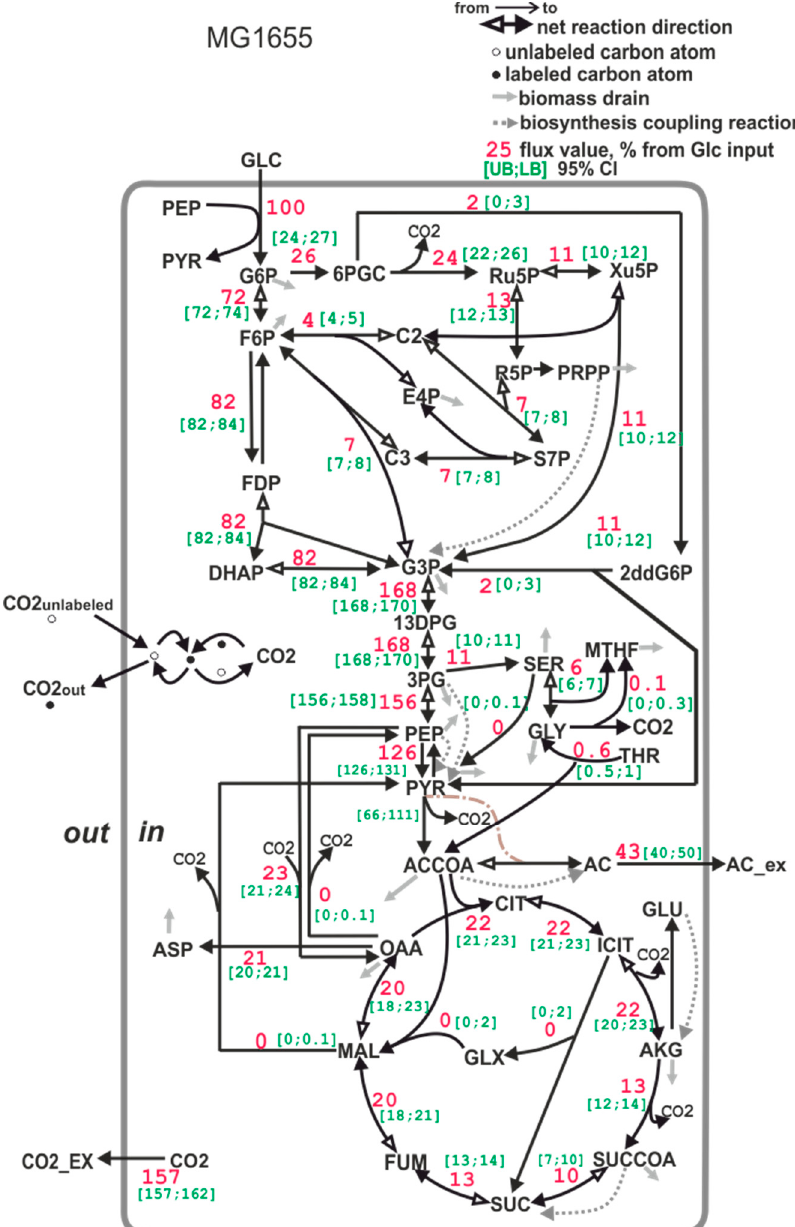
Figure 6. The carbon flux distribution in the E . coli MG1655 strain. Flux through the PEP->PYR reaction is a sum of the PTS-dependent glucose transport reaction and pyruvate kinase reaction. Flux through the pyruvate dehydrogenase reaction is expressed as a range (see Section 2.9.3.) Accounting for serine degradation to pyruvate (activated, for example, in an E. coli pfkA -deficient mutant, see [82]) leads to a broad confidence interval of lumped fluxes of phosphoglycerate mutase and enolase, and of pyruvate kinase flux. All of the fluxes are normalized to a specific glucose uptake rate (mmol/gDW*hour), which is set to 100%. The [UB;LB] 95% CI in the legend is the [Upper bound (UB);Lower bound (LB)] of the 95% confidence interval, calculated as described in Section 2.9.7. The carbon flux distribution of the strain MG1655 IS 5.8::P L -hppa Rru , carrying both na- tive S-PPase and heterologous H + -PPase Rru , is similar to that of the wild-type strain MG1655 (Figure 7). This coincides with the low PPase activity measured in the membrane fraction of this strain. Probably, the H + -PPase Rru characterized by a slower turnover cannot compete with native S-PPase for PP i .